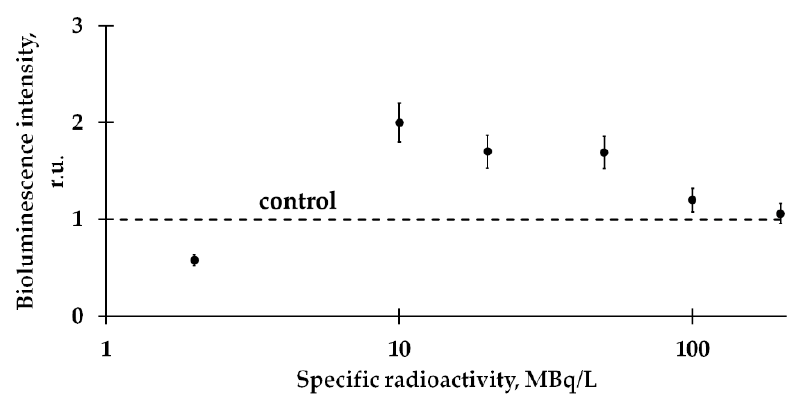
Figure 2. Relative bioluminescence intensity at different specific radioactivities of tritiated water (HTO), 6-h exposure time. Values of the specific radioactivities for the samples used are listed in Section